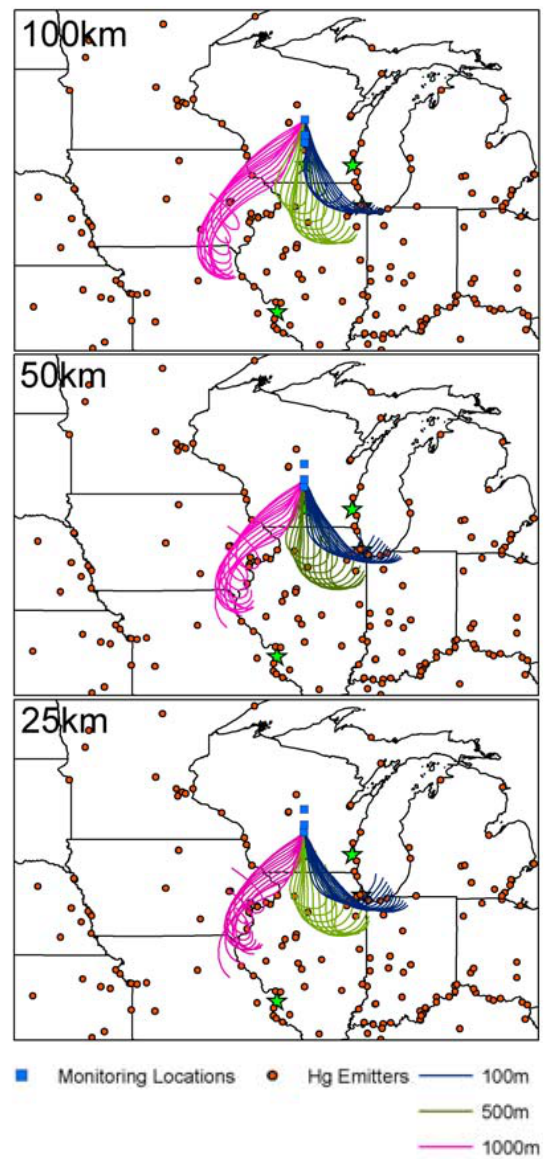
Fig. 8. NOAA HYSPLIT multiple 24-h air mass back trajectory model results for 23 September 2007. 24 h back trajectories begin each hour from 09:00 to 15:00 local time, the period of elevated RGM at each station. Results show variation in source area as a function of air mass height. This plot suggests that multiple source areas contribute to each Hg event observed.